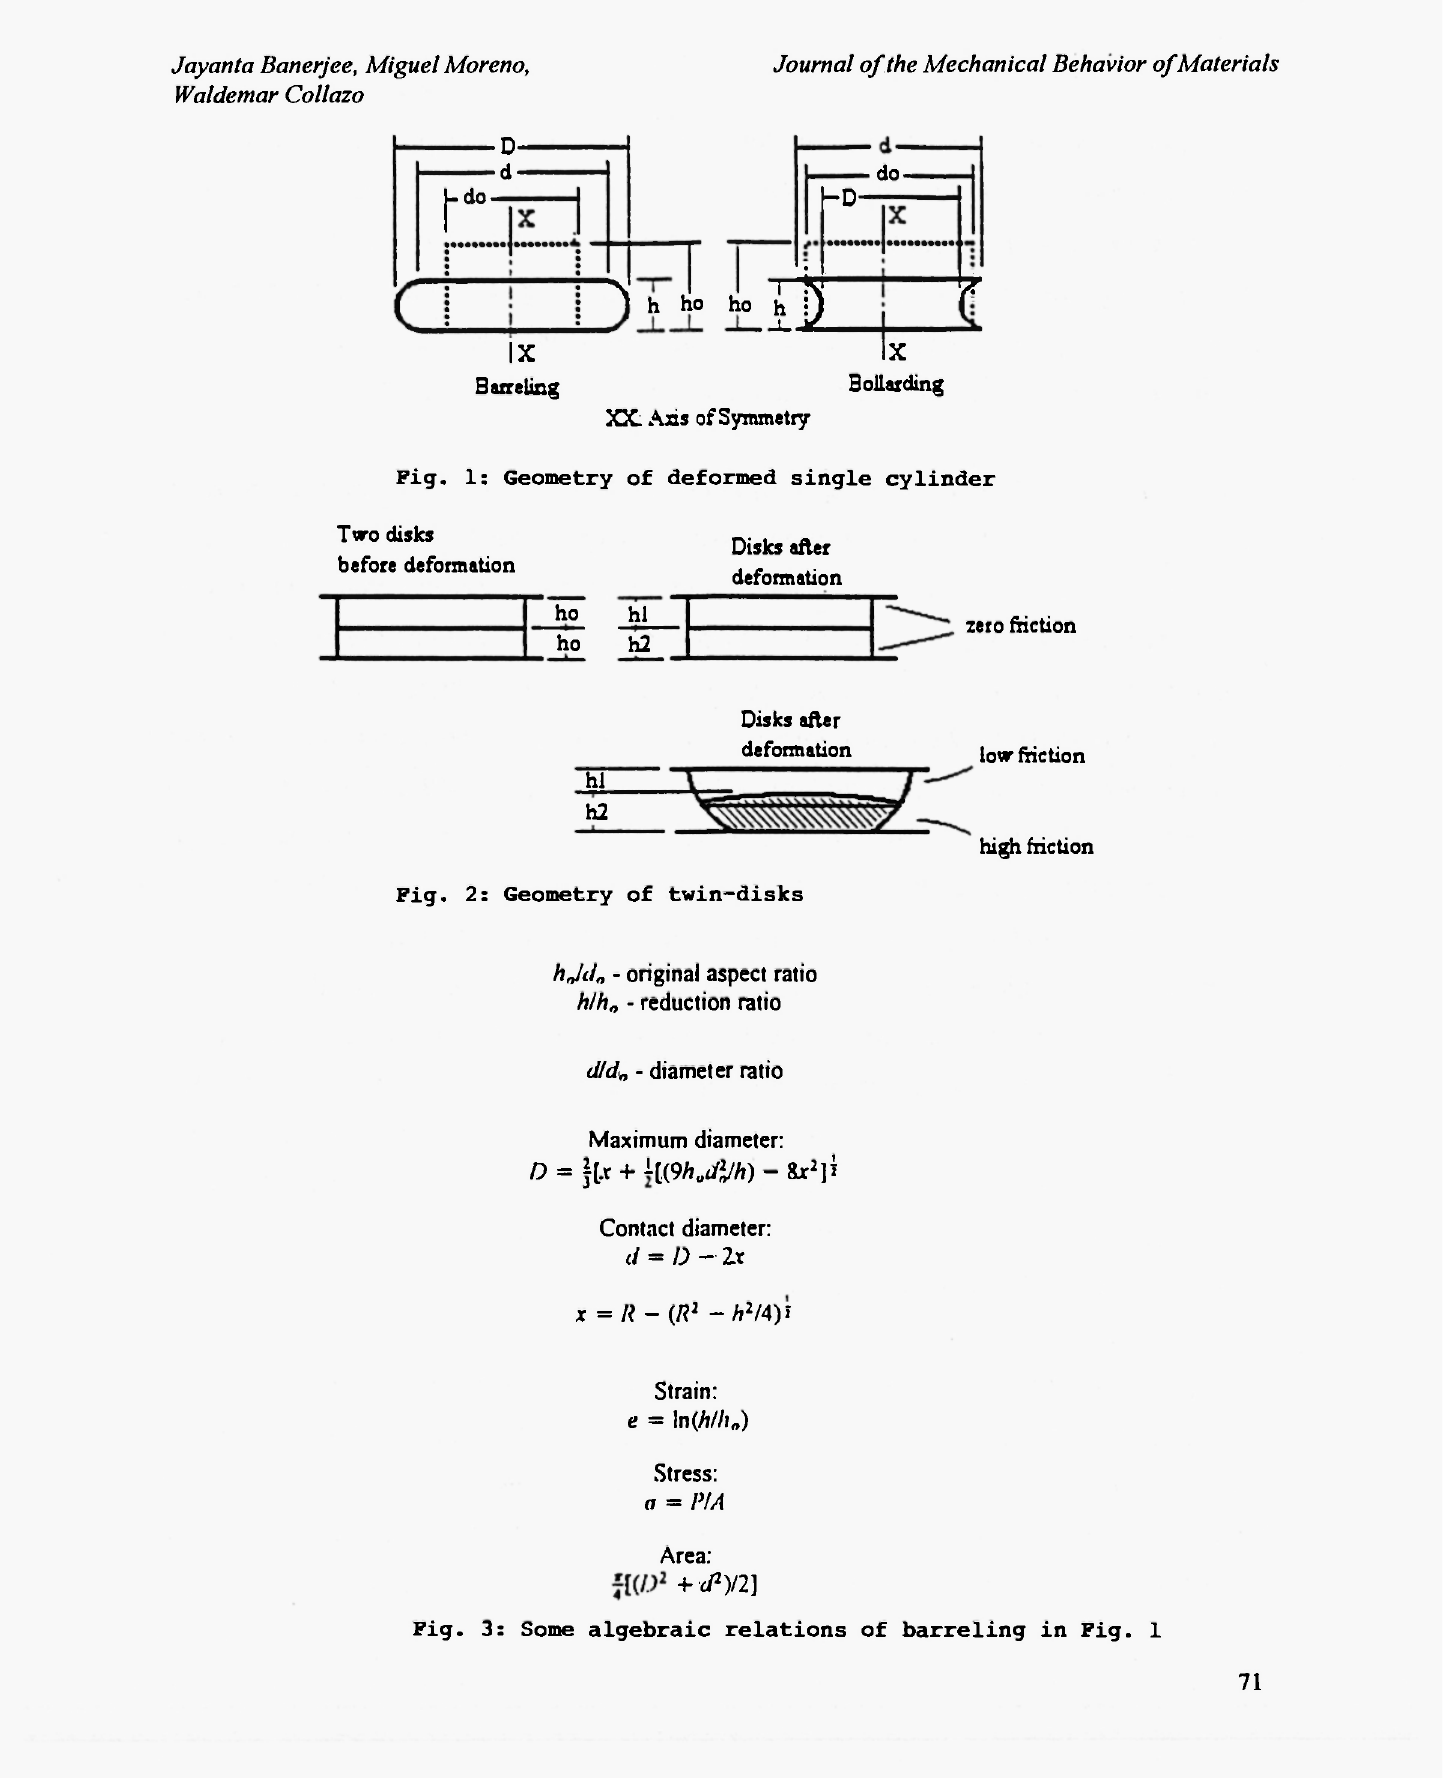
Fig. Is Geometry of deformed single cylinder